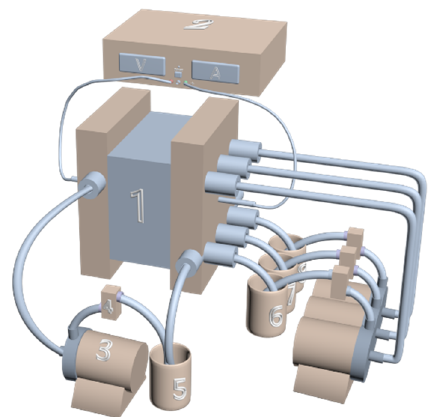
Figure 2. Schematic diagram of BMED system. ( 1 ) BMED system stack; ( 2 ) DC power supply; ( 3 ) centrifugal pump; ( 4 ) rotameter; ( 5 ) electrode rinse tank; ( 6 ) base solution tank; ( 7 ) feed solution tank; ( 8 ) acid solution tank.